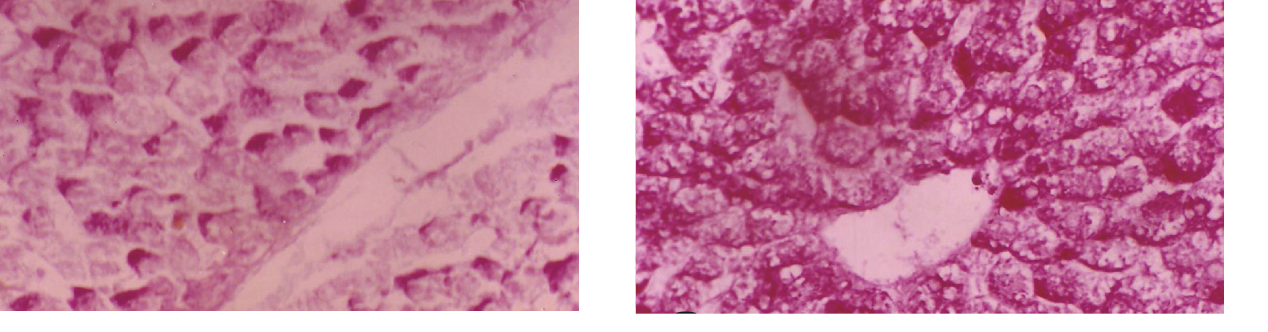
Figure 8: Photomicrograph of liver section of diabetic rat offspring after birth. The stain is less intensive ( × 400).